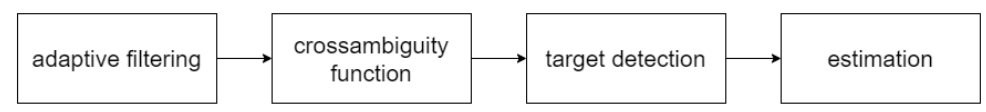
Figure 8. Signal processing stages used in passive radiolocation